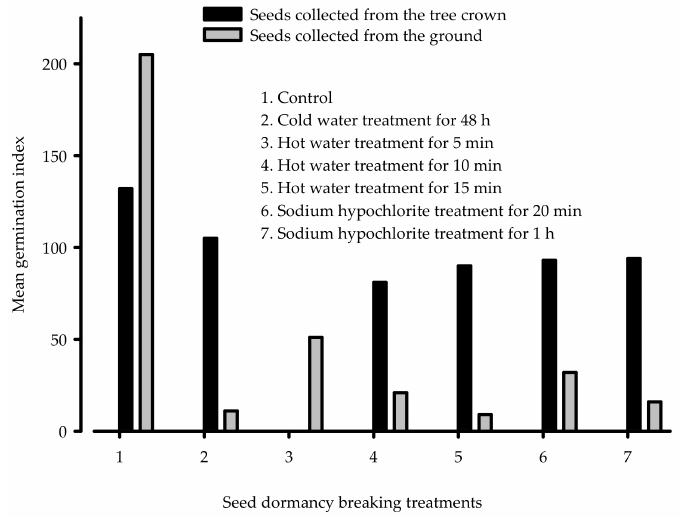
Figure 6. Mean germination index of the D. steudneri seeds collected from the tree and the ground with different presowing treatments in the